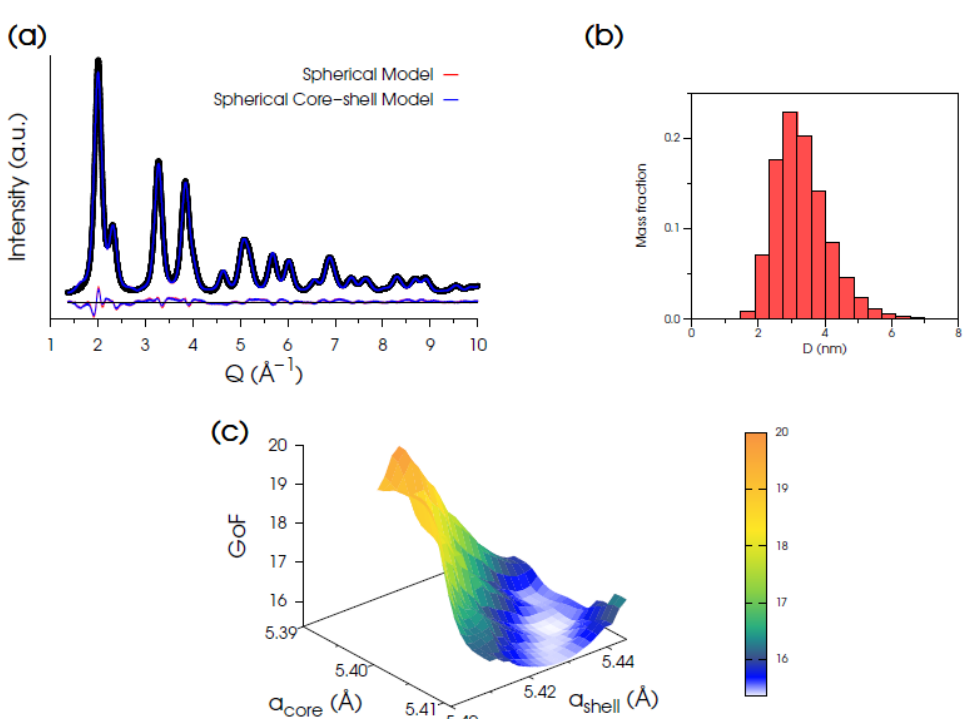
Figure 2. ( a ) Synchrotron XRPD data (black dots) of Ce200 and DSE best fits obtained using either a uniform spherical model (red trace, GoF = 15.54) of CeO 2 NPs or an optimized homo core-shell spherical one (blue line, GoF = 14.99) with diverse lattice parameters in the core and the in shell. ( b ) Histograms of the refined monovariate mass-based lognormal size distribution function of NCs. ( c ) 3D hypersurface of GoF versus a core and a shell explored for the optimization of the homo core-shell spherical model. Table 2. Comparison among the models of CeO 2 NPs tested by DSE against the XRPD pattern of the Ce200 specimen. All the sizes are given as mass-based average values. Model